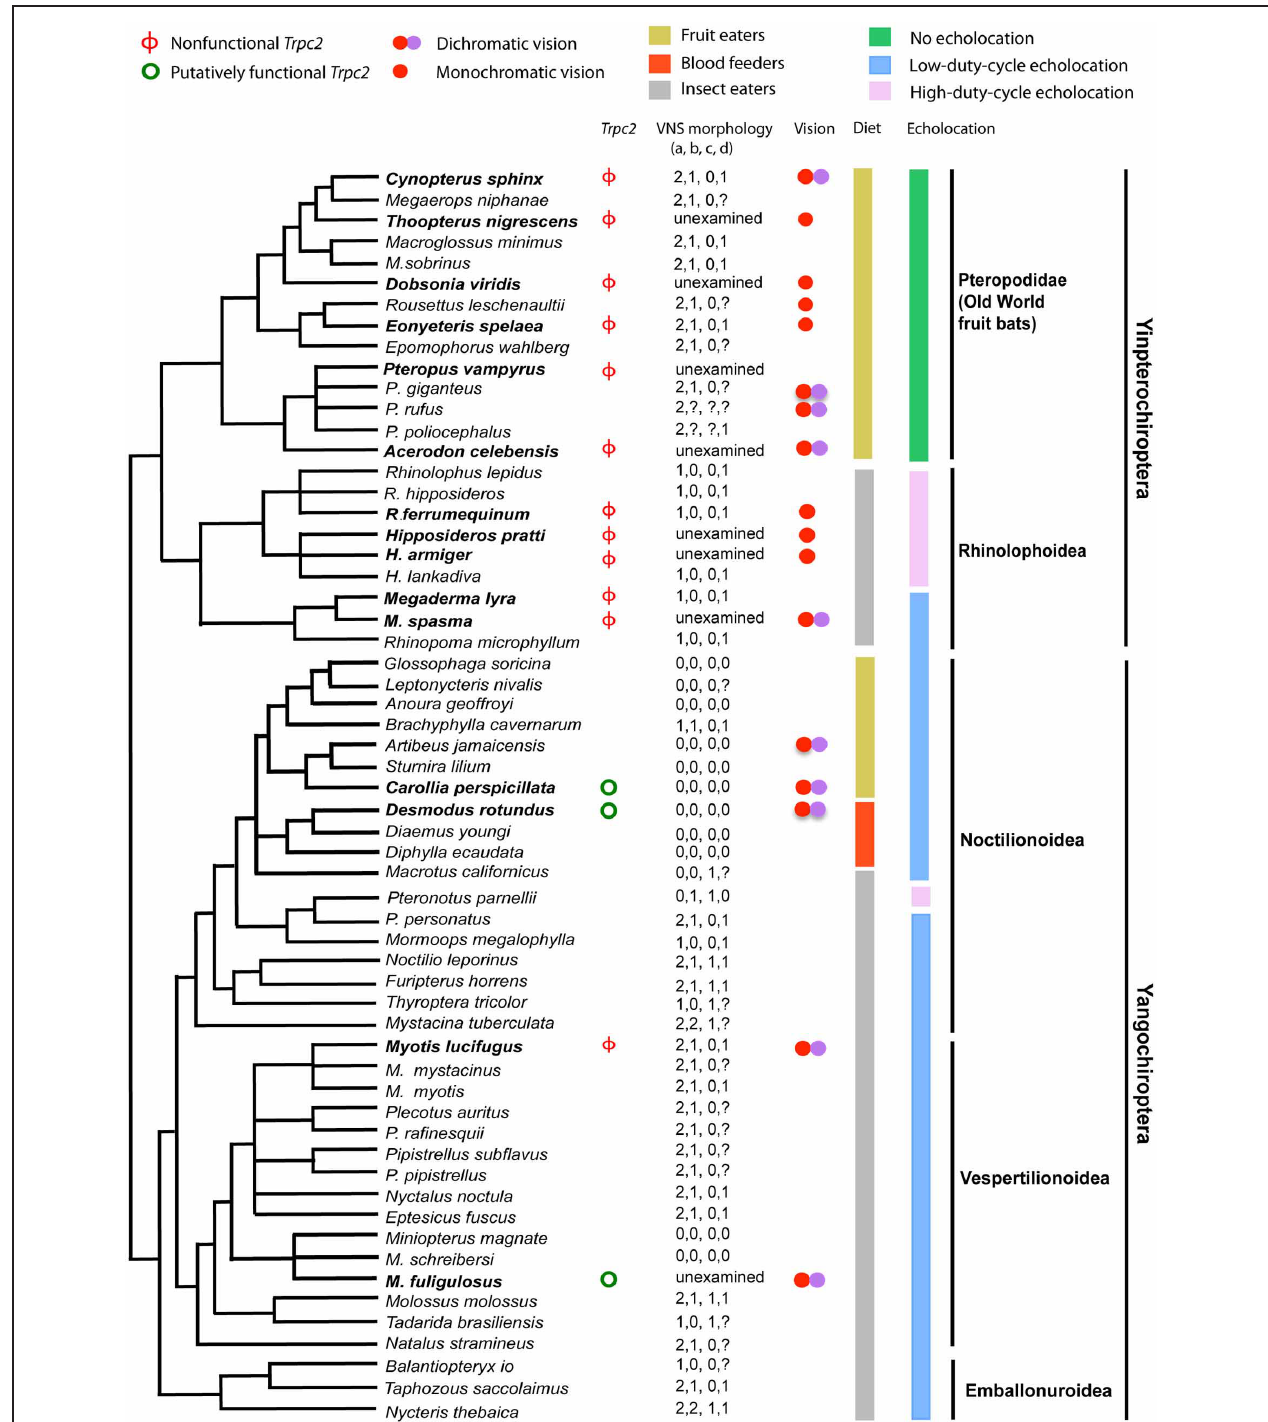
FIGURE 6 | Phylogenetic tree of bats for which information about the vomeronasal system (VNS) is available with information about Trpc2 functionality, physiology and ecology. Species in bold text had exon 2 of Trpc2 sequenced by Zhao et al. (2011). VNS morphology—“a” represents vomeronasal epithelial tube (0 = well developed, 1 = rudimentary, 2 = absent), “b” is vomeronasal cartilage (0 = J, C, U, or O-shaped, 1 = bar-shaped, 2 = absent), “c” is information about the nasopalatine duct